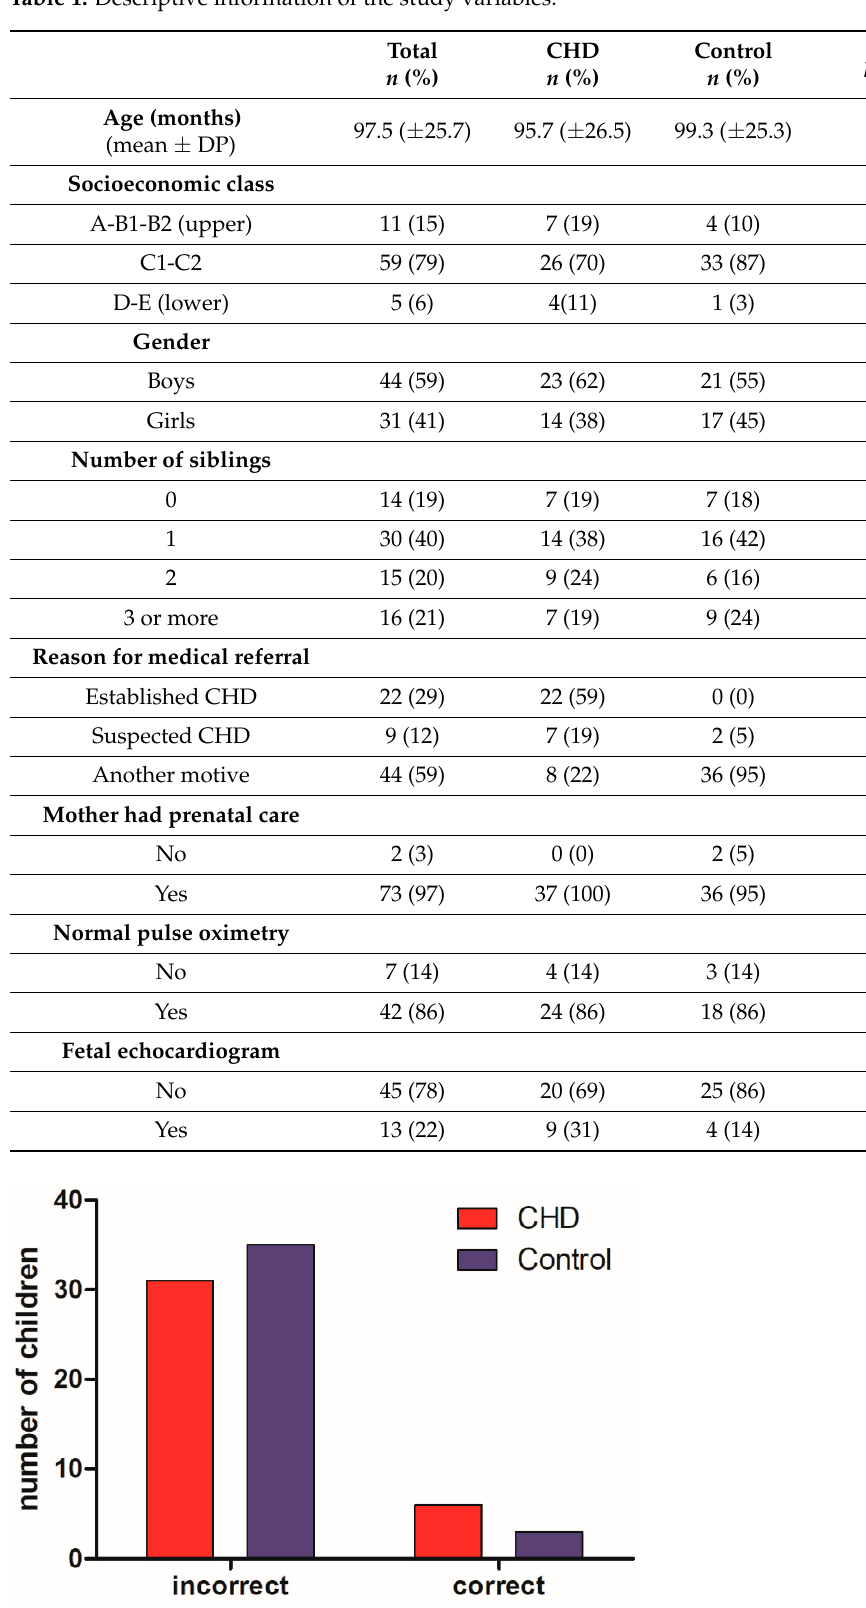
Table 1. Descriptive information of the study variables.